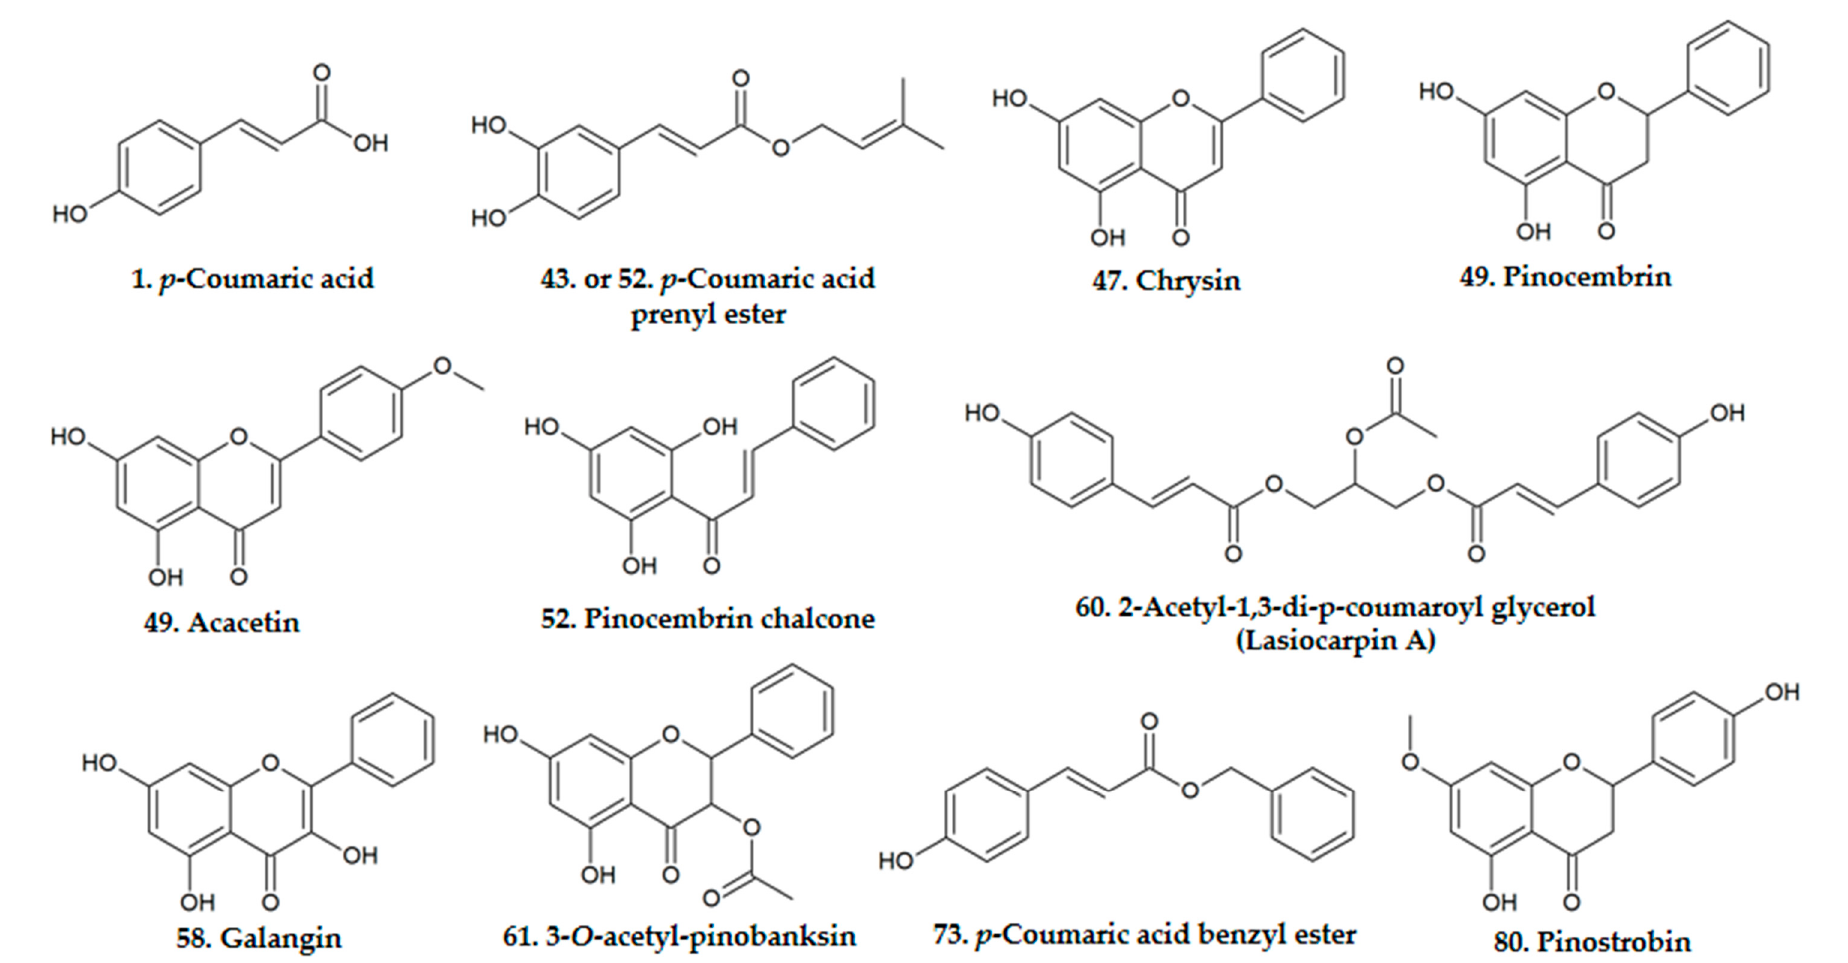
Figure 1. Chemical composition of Eurasian propolis.